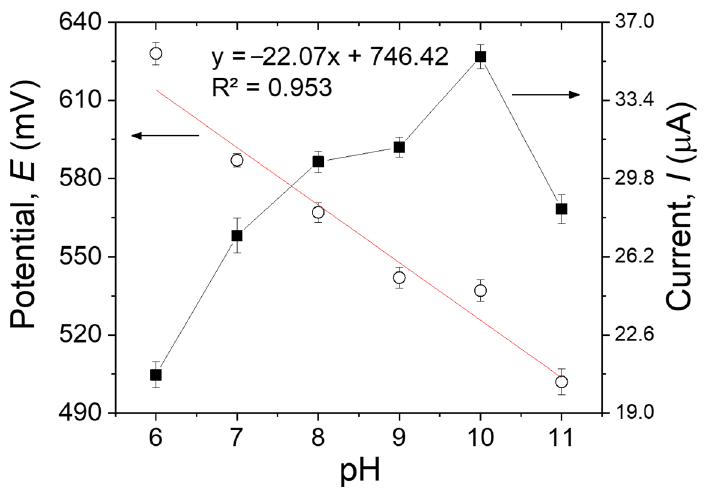
Figure 8. The pH effects on the anodic peak potentials and currents of 500 µM of MDA in B-R buffer solution on the MIP/MWCNTs/GCE. Error bars are calculated from three independent replicates.